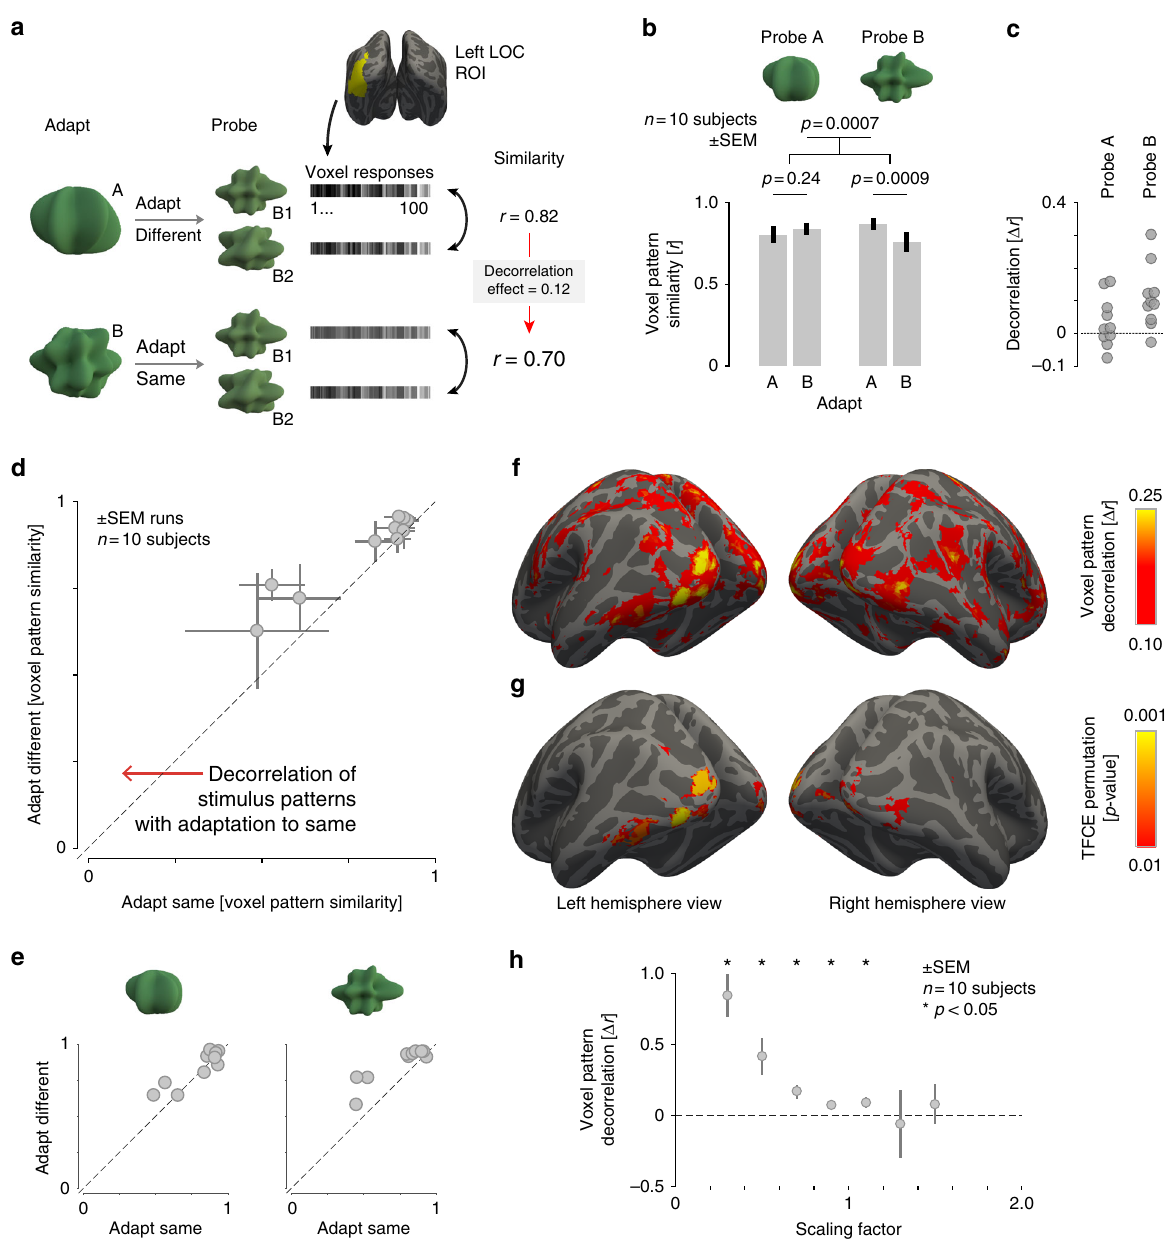
Fig. 3 Voxel pattern discriminability. a Schematic of the fMRI decorrelation analysis. We measured responses in left LO to a pair of probe shapes after adaptation to either shape class A or B. We then computed the similarity of voxel responses evoked by the pairs of probe shapes, and compared the resulting Pearson ’ s correlation for the probe shapes that were either adapted or unadapted. A decorrelation effect was de fi ned as the difference between probe stimuli from the A (left) and B (right) shape classes. Patterns were more distinct (less correlated) for probe shape pairs after undergoing adaptation to the same shape class. Error bars are standard error of the mean across subjects ( n = 10). p -values are shown for paired t -tests. c Magnitude of the were from the same space as the adaptors ( x -axis), to when they were from the different space ( y -axis). For every subject, patterns from adapted pairs of stimuli were less correlated than patterns from unadapted stimuli. Each data point represents one subject and error bars represent variability (SEM) across scan acquisitions within subject. e Correlation between multi-voxel patterns for each subject displayed separately for each probe. f A whole-brain searchlight analysis presenting the mean, across-subject magnitude of the decorrelation effect across the cortex, thresholded at Δ r > 0.10. g A whole-brain decorrelation signi fi cance map obtained from a permutation test with threshold-free cluster enhancement, thresholded at p < 0.01. h Voxel pattern decorrelation measured separately for groups of voxels with varying degrees of response suppression. The scaling factor of each voxel was measured as the ratio between mean response in the adapted condition vs. mean response in the unadapted condition. Error bars represent variability (SEM) across subjects and asterisks denote signi fi cant ( p < 0.05) decorrelation assessed with a paired t